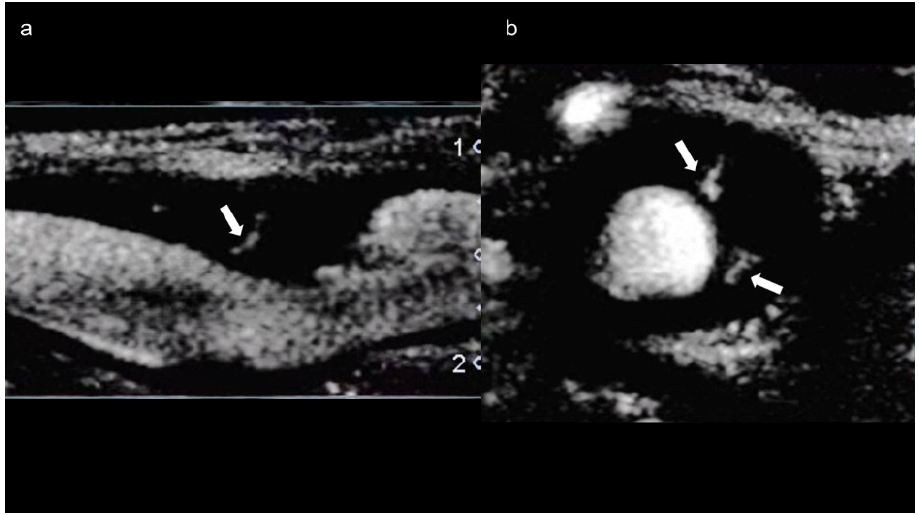
Figure 6. SMI of a 64-year-old man with asymptomatic carotid stenosis. Blood flow signals are seen in both ( a ) long-axis (arrow) and ( b ) short-axis (arrows) images.